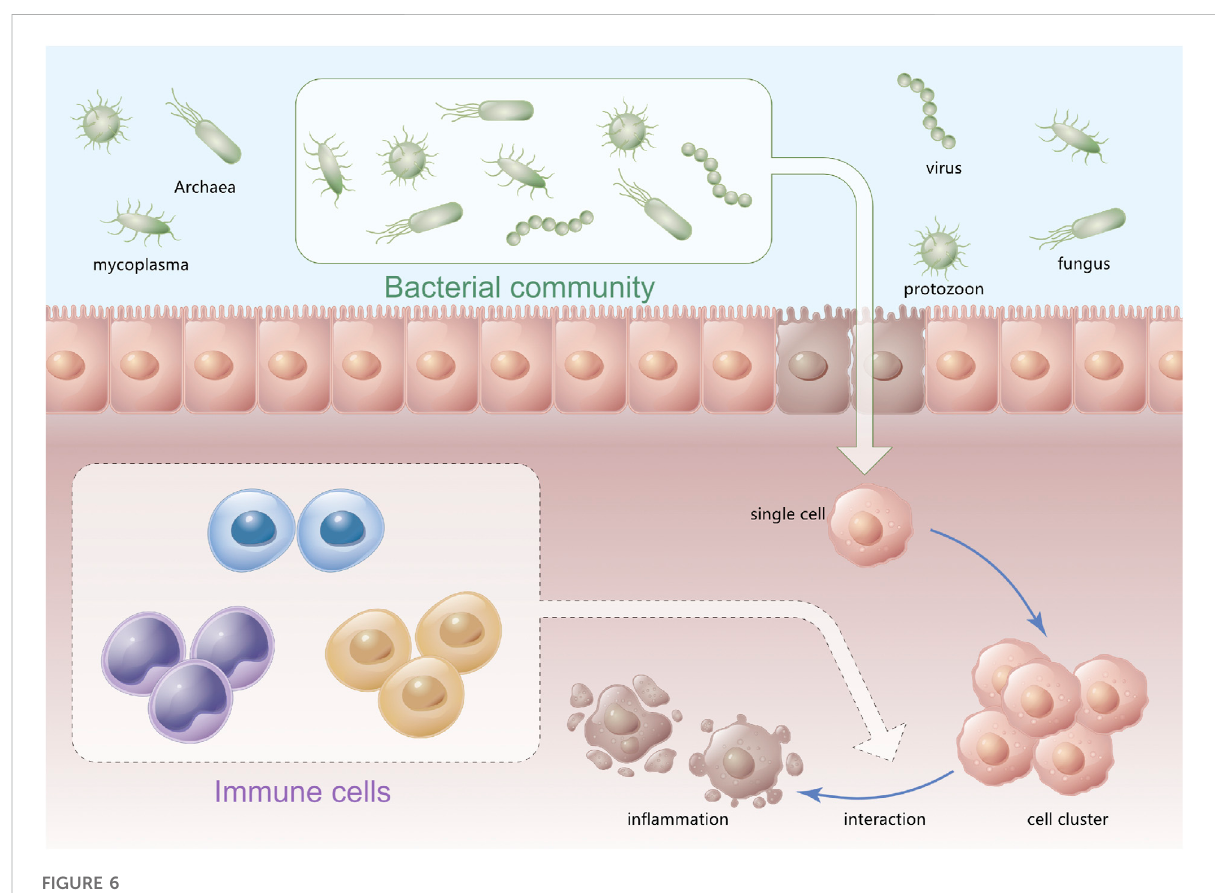
FIGURE 6 Relationship between immune cells and